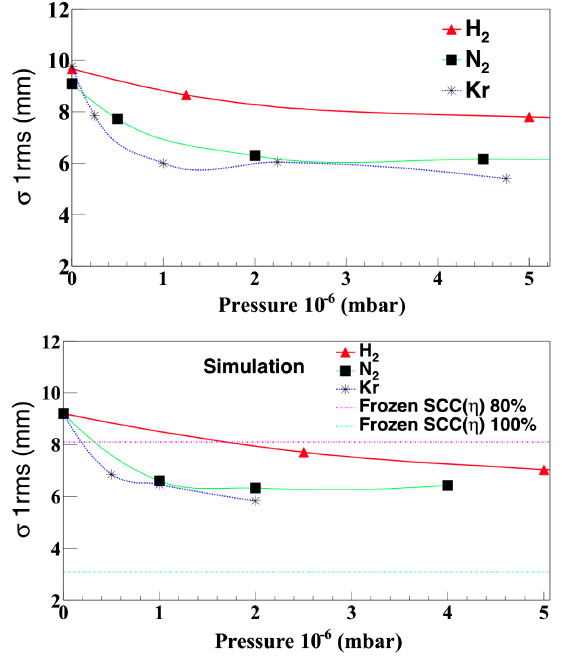
FIG. 17. Beam size versus injected gas pressure for measure- ments (top) and simulations (bottom), for different injected gas